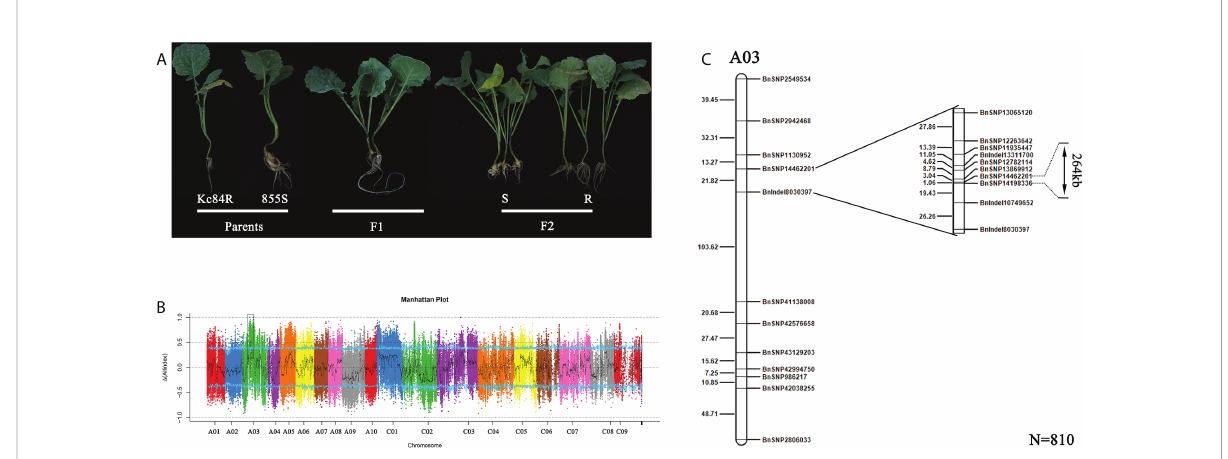
FIGURE 2 Mapping of candidate CR locus. (A) Phenotype identi fi cation of two parent lines and their crossed offspring after inoculation with Pb Gh. (B) The CR loci identi fi ed by BSA-sequencing (BSA-seq). (C) Fine mapping of the CR locus based on SNP markers using 810 F 2 individuals. The genetic distance is shown on the left, the physical locations of SNP markers are included in the